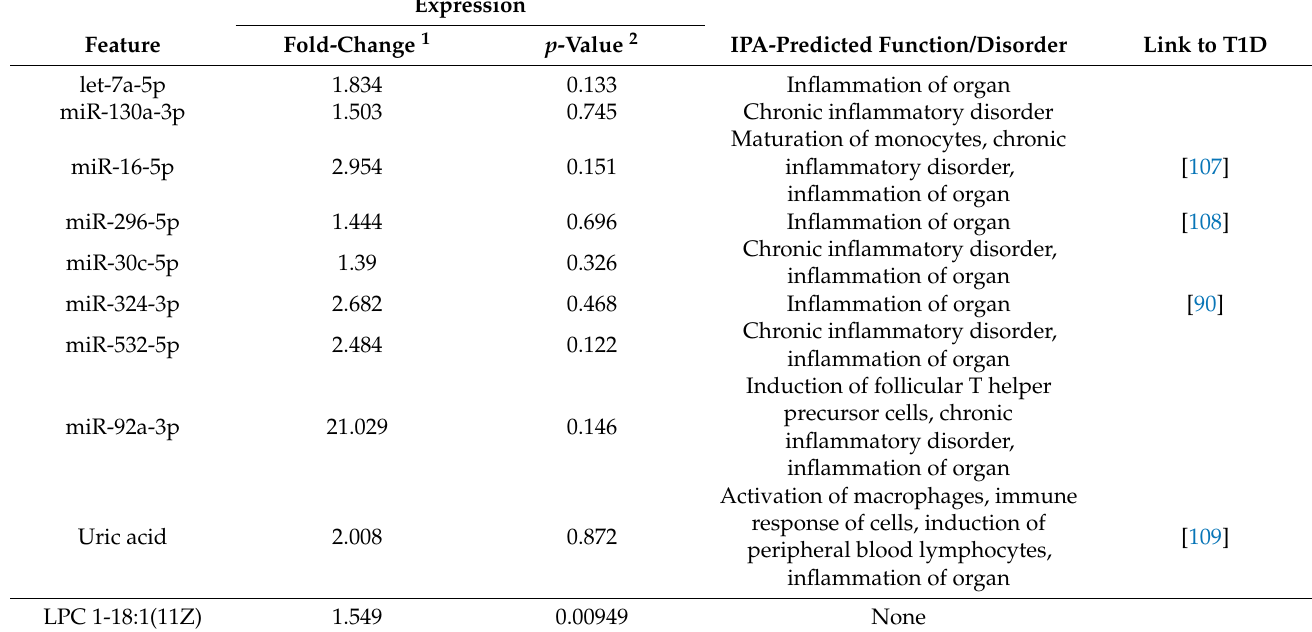
Table 2. A potential integrated biomarker signature in high-risk T1D subjects. Features were selected from those predicted by IPA in each omics dataset based on their involvement in central nodes within the global molecular network generated from the combined quadra-omics dataset at cutoff value of 1.1.